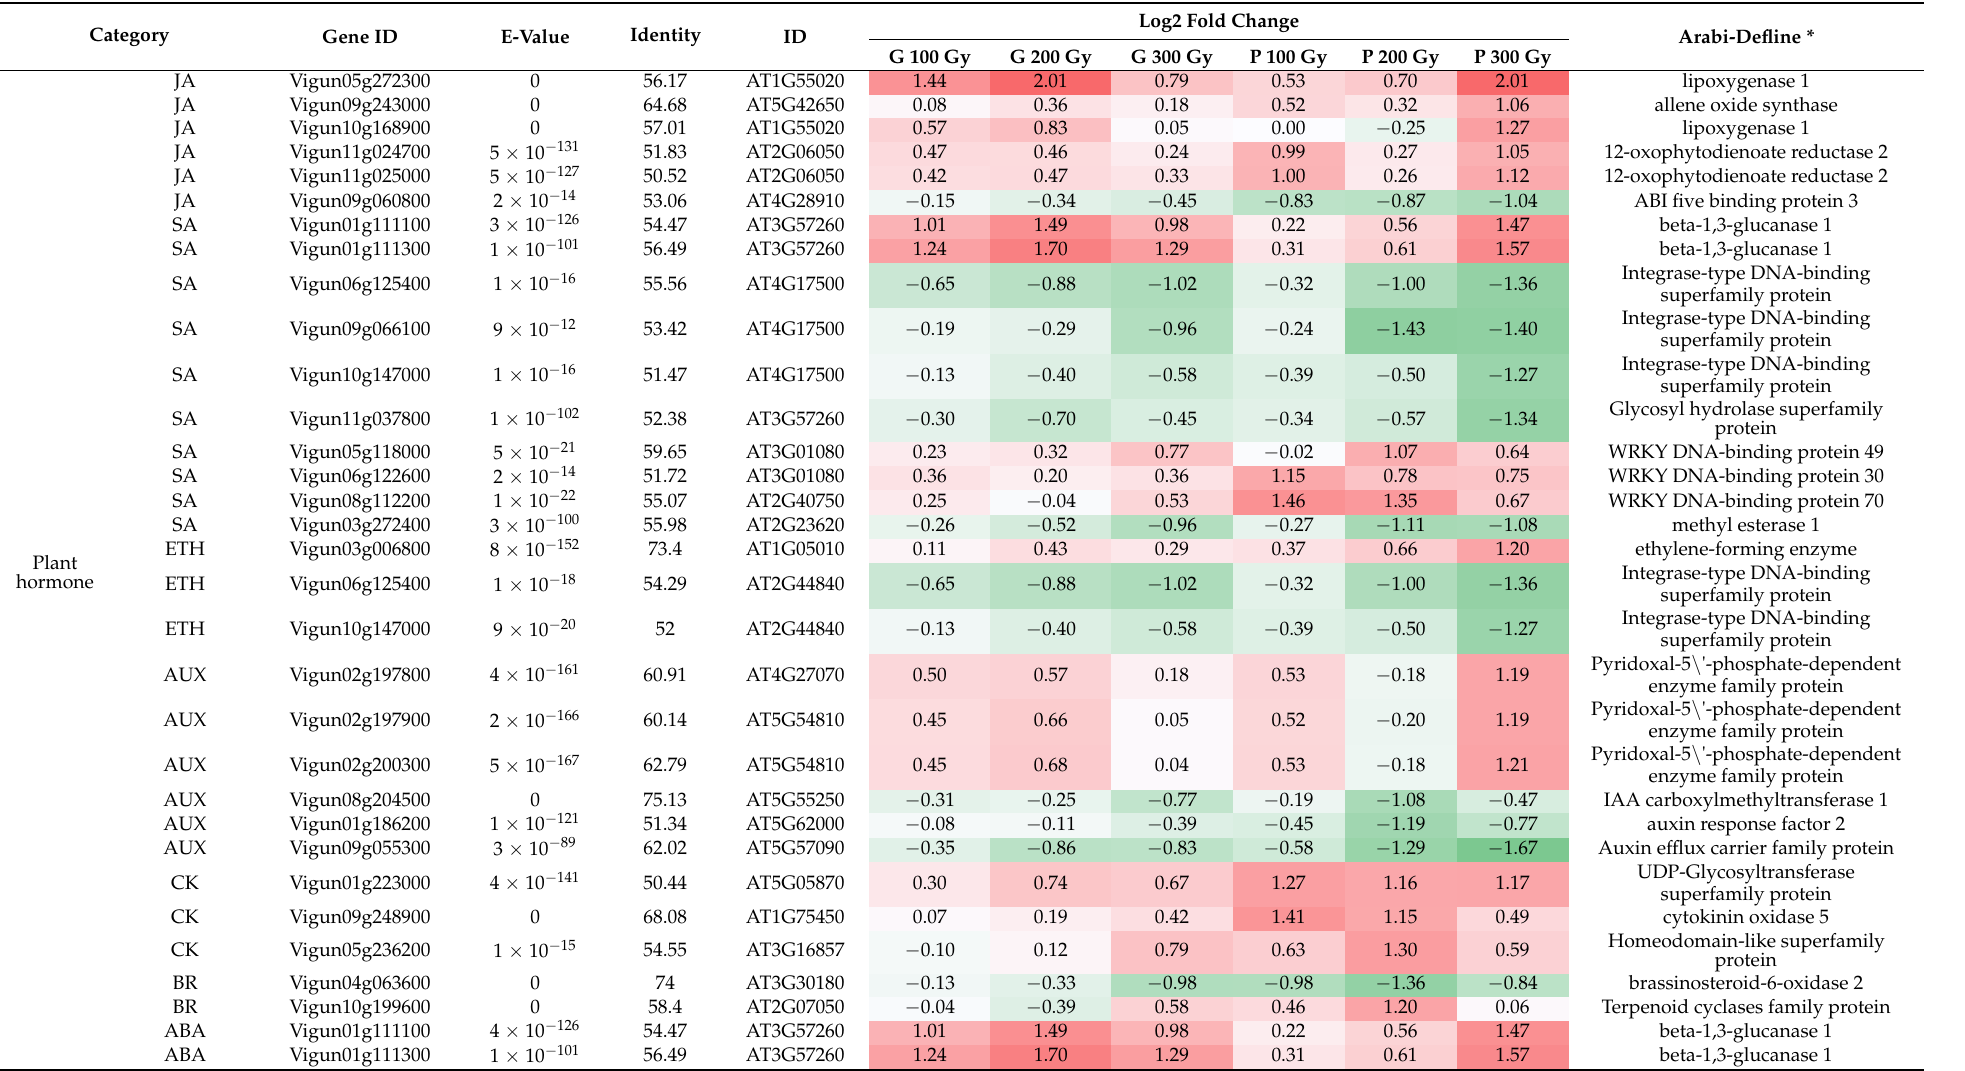
Table 4. The differently expressed genes (DEGs) list related to plant hormone, TF of cowpeas exposed to different dose rates of gamma-rays and